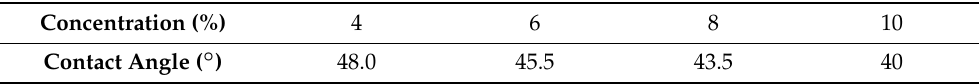
Table 7. The contact angle between the water and W-OH at various concentrations. Concentration (%) 4 6 8 10 Contact Angle ( ◦ ) 48.0 45.5 43.5 40 According to Equations (11)–(15), the adhesion work, W SL , between W-OH (at various concentrations) and the Pisha sandstone, meaning the specific surface energy change value ∆ G ∆ G SL in the two-phase system and SLW in the three-phase system, can be calculated, as shown in Table 8. The relationship between | ∆ G SL | and concentration and the relationship between | ∆ G SLW | and concentration are fitted respectively, as shown in Equations (16) and (17). And it is found that the absolute value for both satisfies the linear function well with the W-OH concentration.